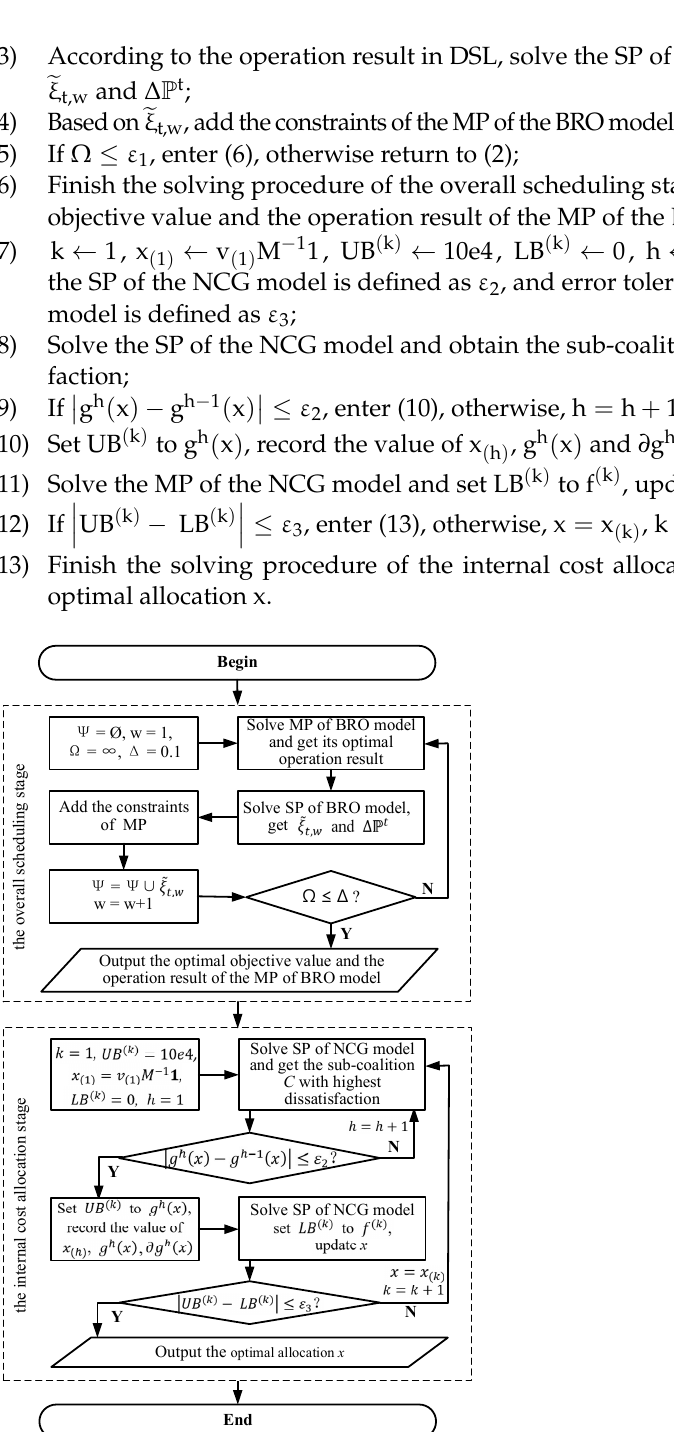
Table 1. Relevant parameters for components in the MGS .